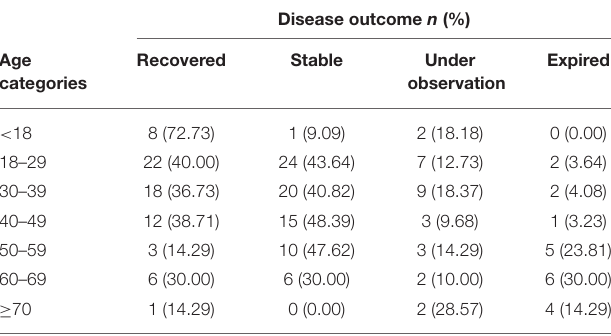
TABLE 3 | Disease outcome status with categorical age-wise distribution. Disease outcome n